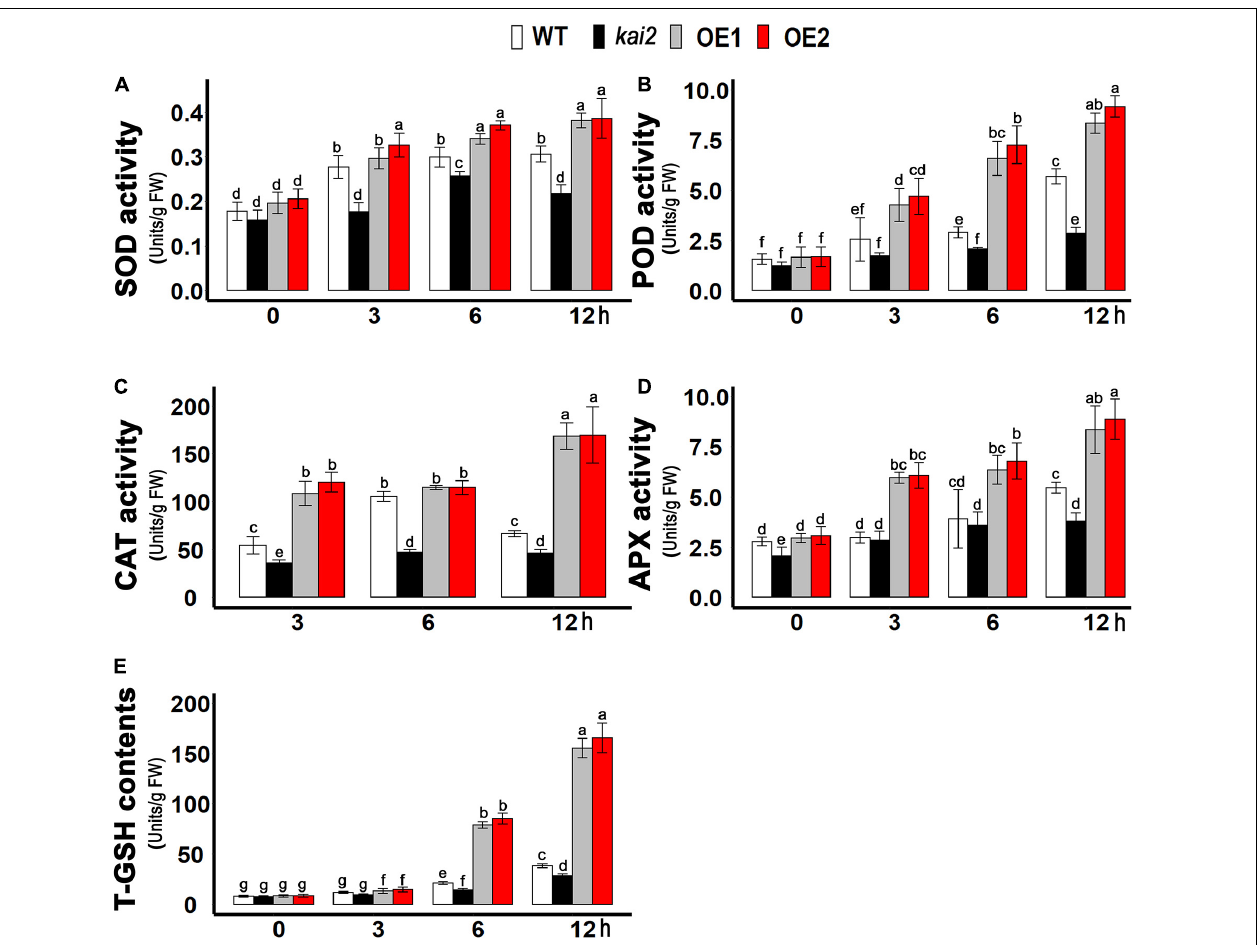
FIGURE 5 | Anti-oxidants contents raised in SsKAI2 OEs under cold stress. (A) SOD. (B) POD. (C) CAT. (D) APX. (E) T-GSH. Twenty-five-day-old plants were subjected to cold treatment. The samples were randomly taken from the leaves of three plants of each genotype after 0 − , 3 − , 6 − , and 12 h under cold treatment (4 ◦ C). One-way ANOVA was used to analyzed all data, and HSD Tukey’s test was used to perform multiple comparisons at P < 0.05 significant level ( n = 3). Bars with uncommon letters showing significant difference at P <